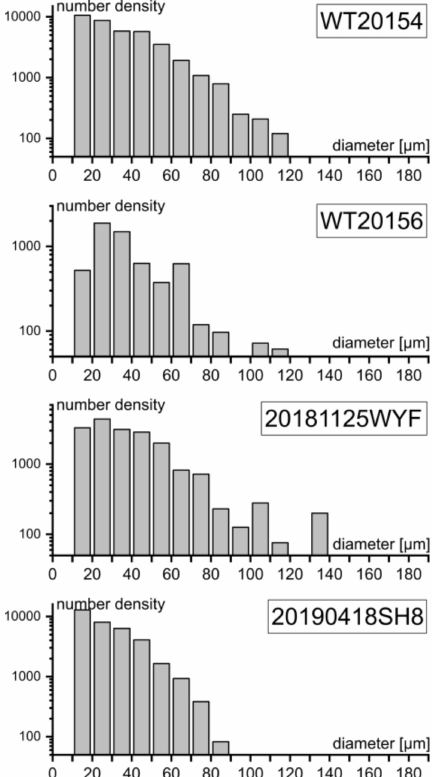
Figure 4. 2D crystal size distribution in Figure 3 converted into 3D number density. Samples No. WT20156 and No. 20181125WYF contain the larger garnet grains that exist more frequently than